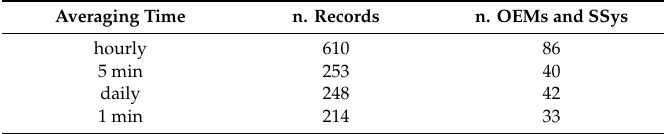
Table A1. Number of analyzed records and sensor models by averaging time.